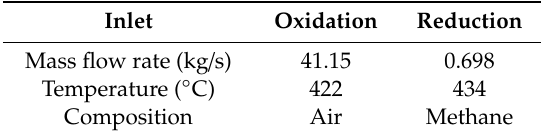
Table 1. Summary of the conditions for the inlets of the two reactor sections. Inlet Oxidation Reduction Mass flow rate (kg / s) 41.15 0.698 Temperature ( ◦ C) 422 434 Composition Air